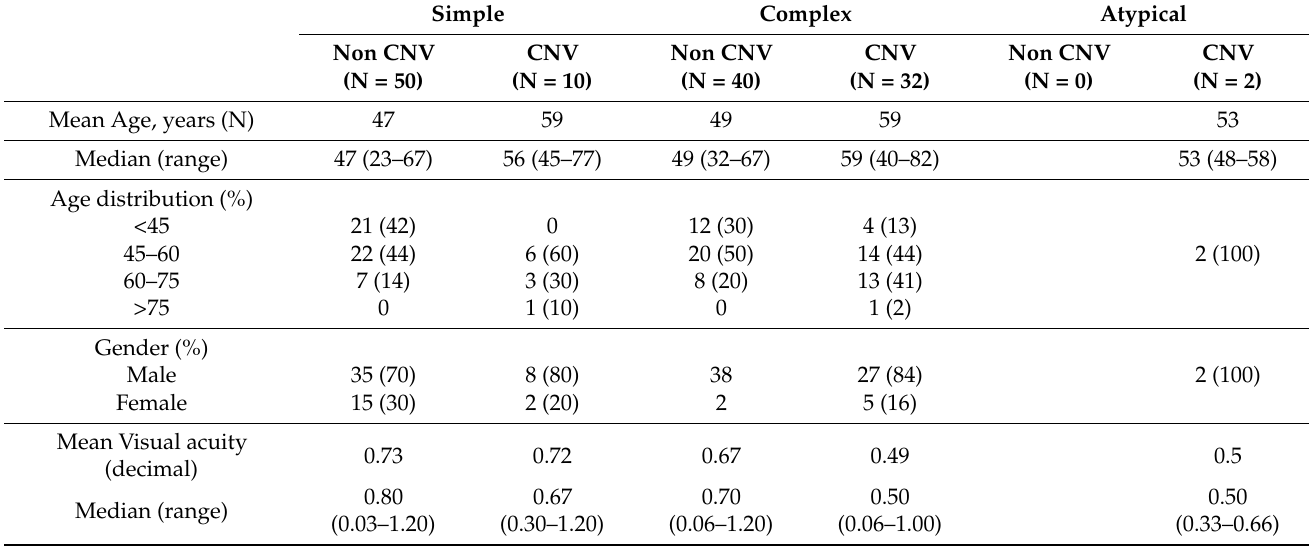
Table 2. Demographics of CNV and Non-CNV in Central Serous Chorioretinopathy: Multimodal Imaging-Based Classification: Simple, Complex vs. Atypical.